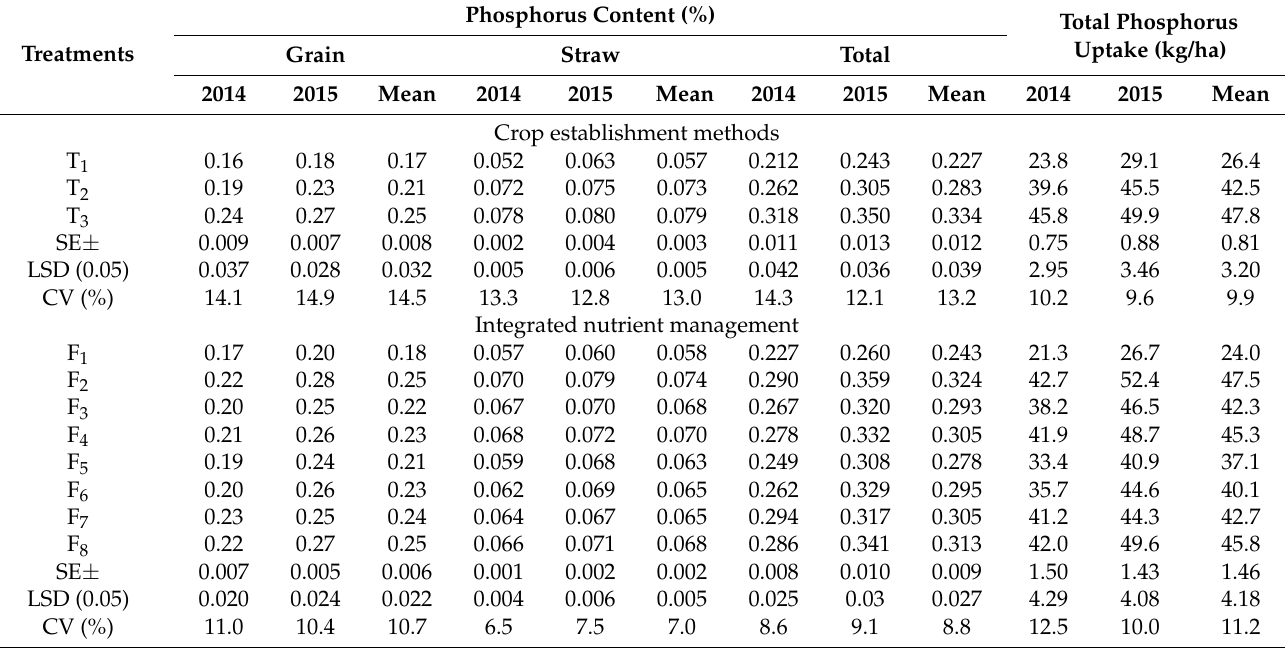
Table 2. Crop establishment methods and integrated nutrient management influence the phosphorus contents and phos- phorus uptake by rice.